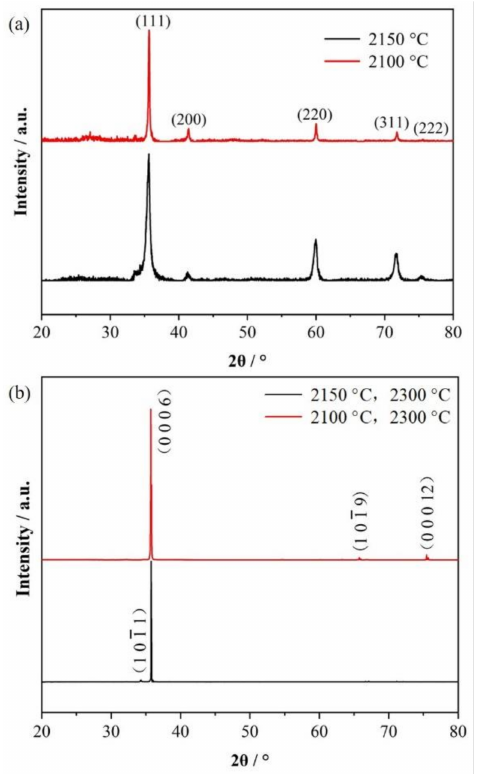
Figure 10. The XRD of the SiC samples: ( a ) grown at 2100 and 2150 ◦ C for 10 min; ( b ) further grown at 2300 ◦ C for 4